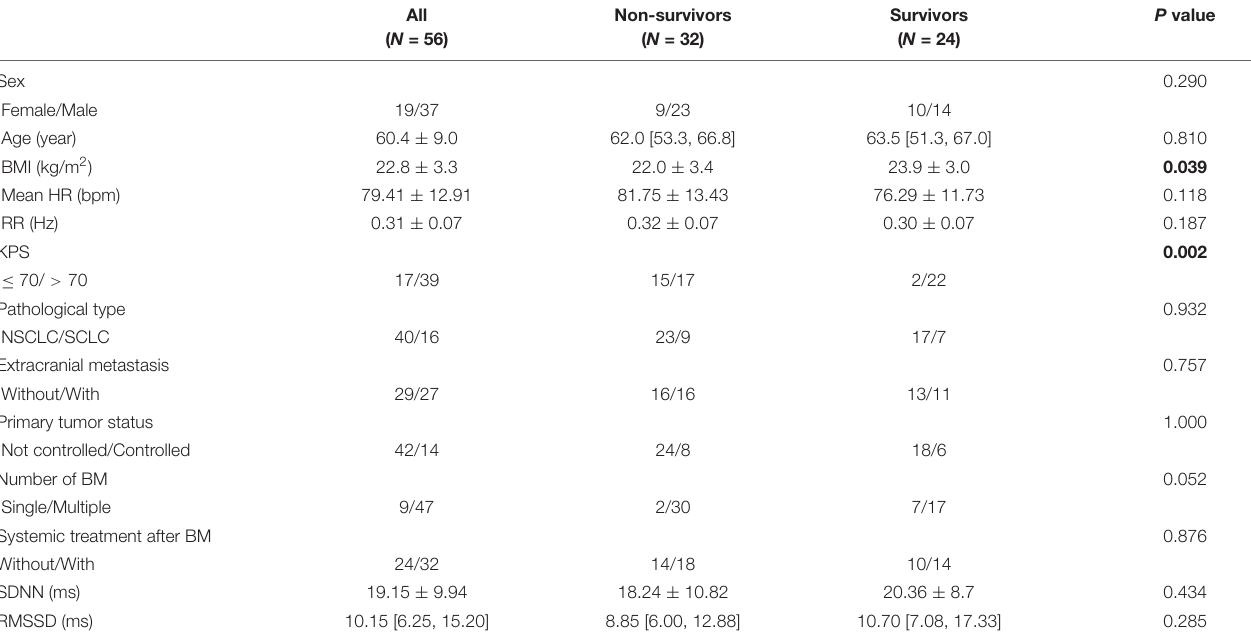
TABLE 1 | General characteristics of all patients and comparison of parameters between non-survived and survived